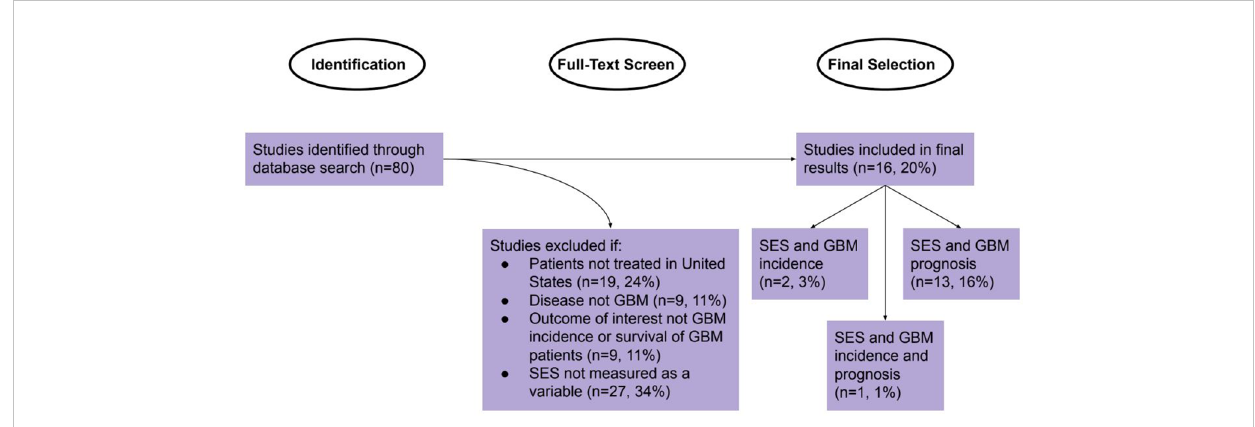
FIGURE 1 Identi fi cation, Screening, and Selection of Studies for